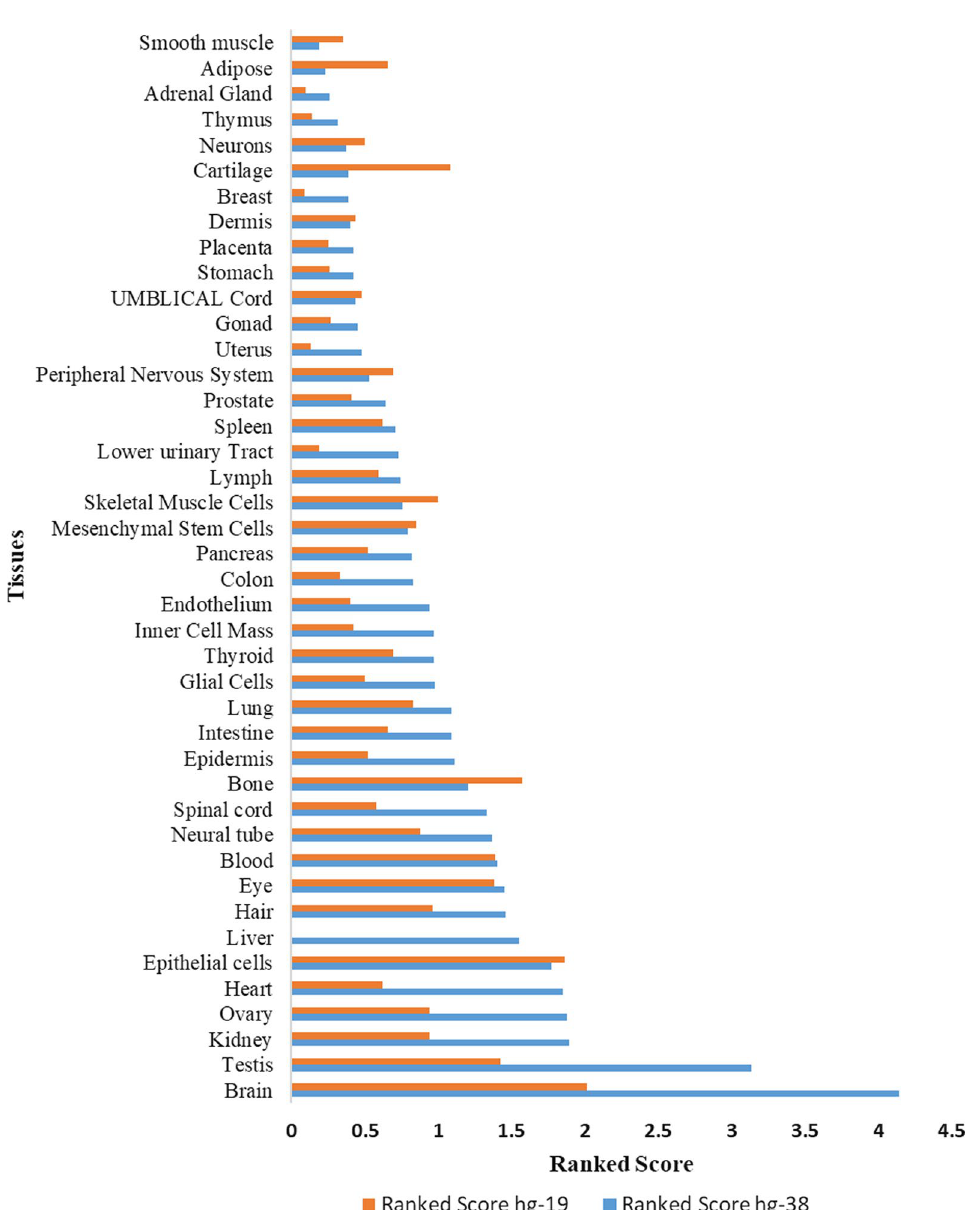
Fig. 2 Distribution of Genes of Mural and Cumulus Granulosa Cells in Tissues as per the Ranked Score. GeneAnalytics-described tissue distribution patterns for genes in murine and cumulus cells, ordered by expression level. Colour represents the hg-19 and hg-38 systems, and the horizontal bar represents the ordered score of the identified genes according to the bodily tissues along the horizontal